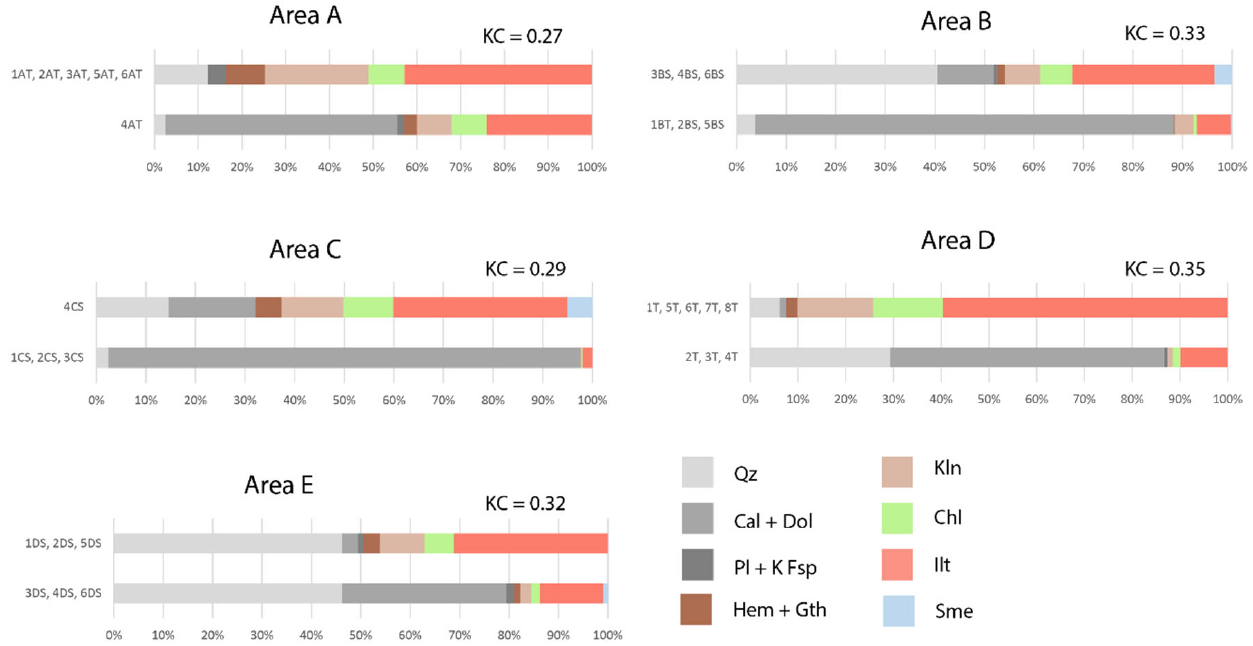
Figure 4. Average of the relative proportions of the mineral phases present in the samples from each area of the cave. The diagrams for each area include two horizontal bars representing samples with high and low carbonate content. The average value of kaolinite crystallinity (KC) in each area is also indicated. Lower values indicate higher kaolinite crystallinity, and viceversa. Qz = Quartz; Cal = Calcite; Dol = Dolomite; Pl = Plagioclase; K Fsp = Potassium Feldspar; Hem = Hematite; Gth = Goethite; Kln = Kaolinite; Chl = Chlorite; Ilt = Illitic Phases; Sme = Smectite. The average values for the kaolinite crystallinity are also indicated in Figure 4 and the kaolinite crystallinity value of each sample is included in Table S2 (Supplementary Materials). According to these data, kaolinite is more crystalline in area A, where its content is higher. Its crystallinity decreases in the rest of the areas, coinciding with the decrease in this mineral content towards the interior of the cave. The lowest kaolinite crystallinity is recorded in area D, where kaolinite content is higher than in areas B, C, and E. Finally, kaolinite is more crystalline in the bedrock sample (0.12) than in the soil sample (0.37) (Table